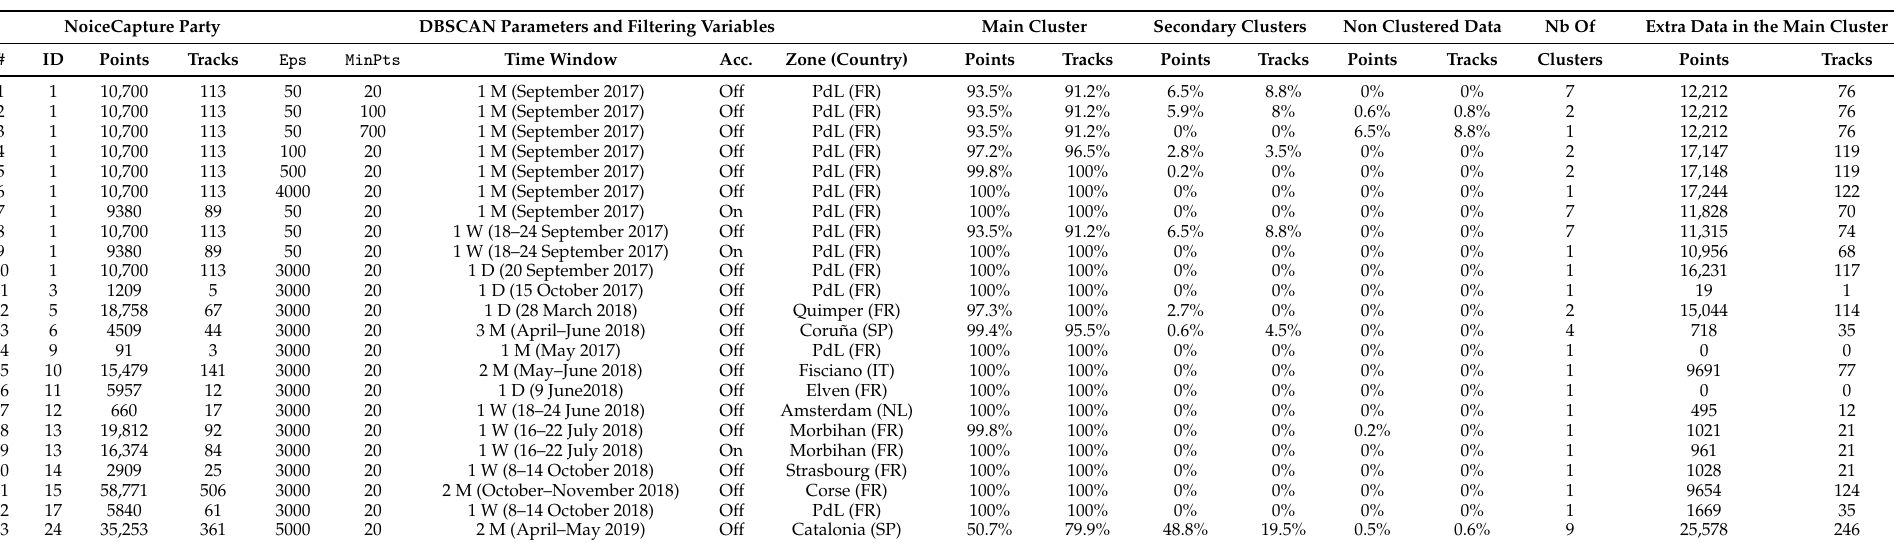
Table 2. Each line corresponds to a simulation with specific DBSCAN parameters ( Eps and MinPts ) and filtering variables (time window, accuracy, and zone), in order to determine if the clustering analysis is able to detect an NC party. The number and percentage of the detected NC points/tracks in the main cluster and possible secondary clusters are given, as well as the missing NC points/tracks (non-clustered NC data), and the extra points/tracks in the main cluster (i.e., points/tracks that are not linked to the corresponding NC party). Only 22 out of more than 600 results are displayed in this table. Notations: “Time window”: “M” month; “W” week; “D” day; Country: “FR” France; “SP” Spain; “IT” Italy; “NL” The